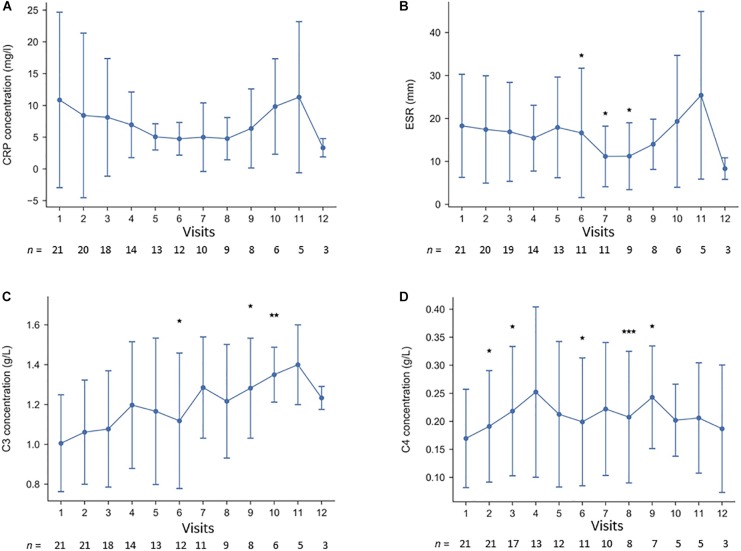
(A–D) Longitudinal laboratory efficacy data at the first 12 visits of the 21 cases that passed the 3-month evaluation visit; (A) C-reactive protein, (B) erythrocyte sedimentation rate, (C) complement protein 3, and (D) complement protein 4. ∗p < 0.05, ∗∗p < 0.01, and ∗∗∗p < 0.005.